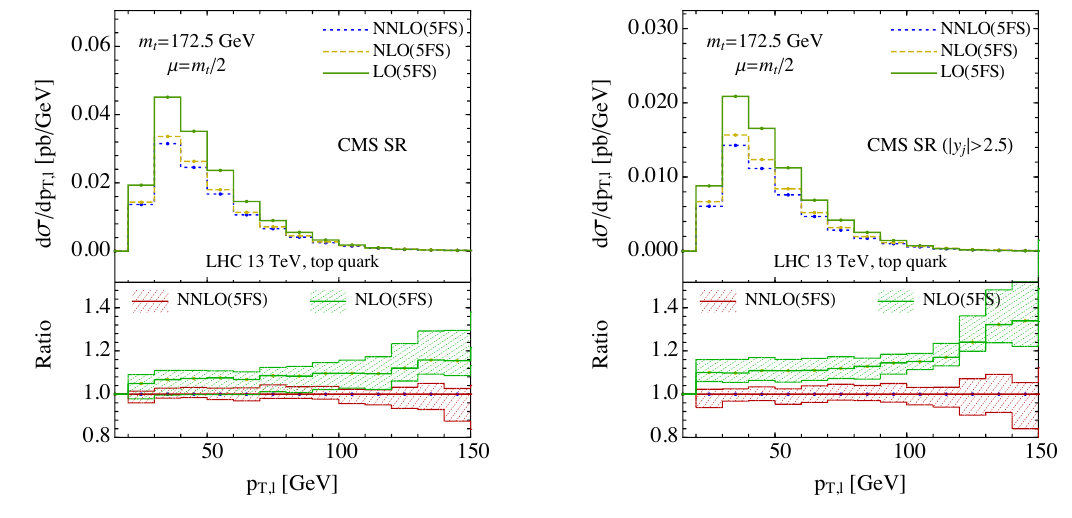
Figure 3 . Transverse momentum distribution of the charged lepton within the two fiducial regions at various orders in QCD in the 5FS for LHC 13 TeV. Scale variations are evaluated by taking envelop of results with 9 scale